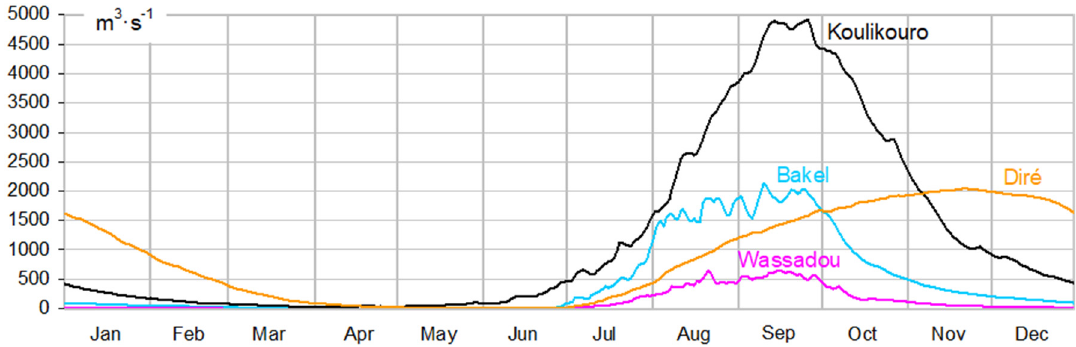
Figure 2. Median annual hydrographs for Senegal at Bakel (rank 23), Gambia at Wassadou upstream (rank 36), Niger at Koulikouro (rank 40) and Niger at Diré (rank 51) over the period 1970–1979.